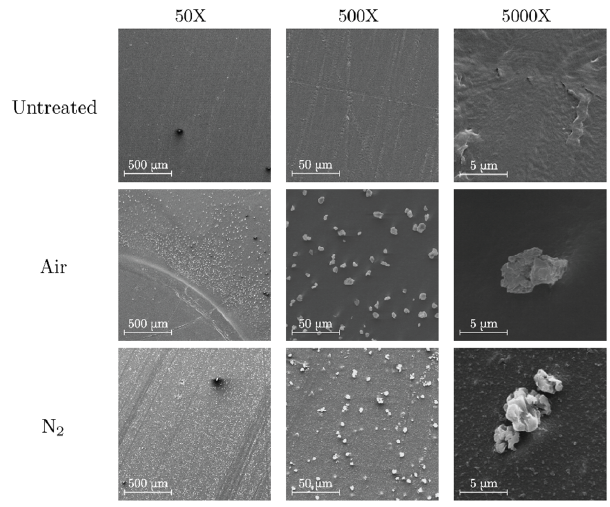
Figure 2. SEM images of untreated (top), air-treated (center) and nitrogen-treated (bottom) polyethylene